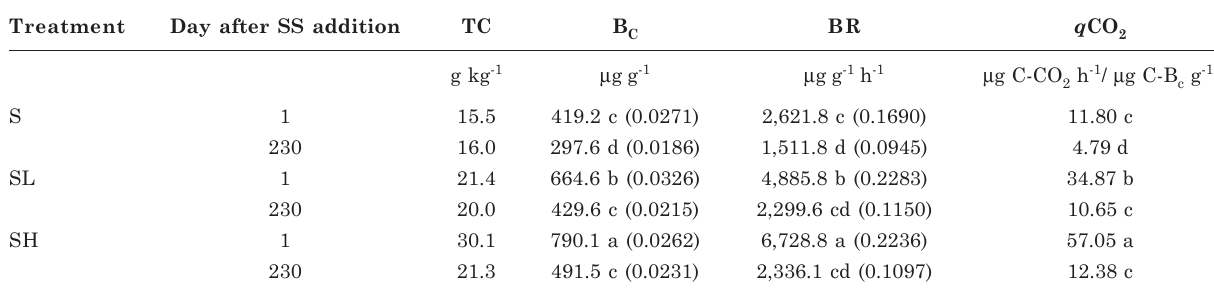
Table 3. Total carbon (TC), microbial biomass carbon (B C ) and its respective percentages in relation to total C (values in parentheses), basal respiration (BR) and its respective percentages in relation to total C (values in parentheses) and microbial metabolic quotient ( q CO 2 ) of soil and sewage sludge-treated soils